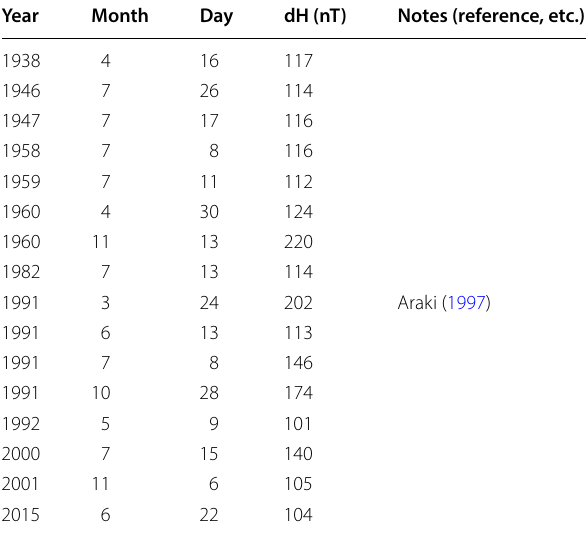
Table2 Largest SC events of dH > 100 nT at KAK since May